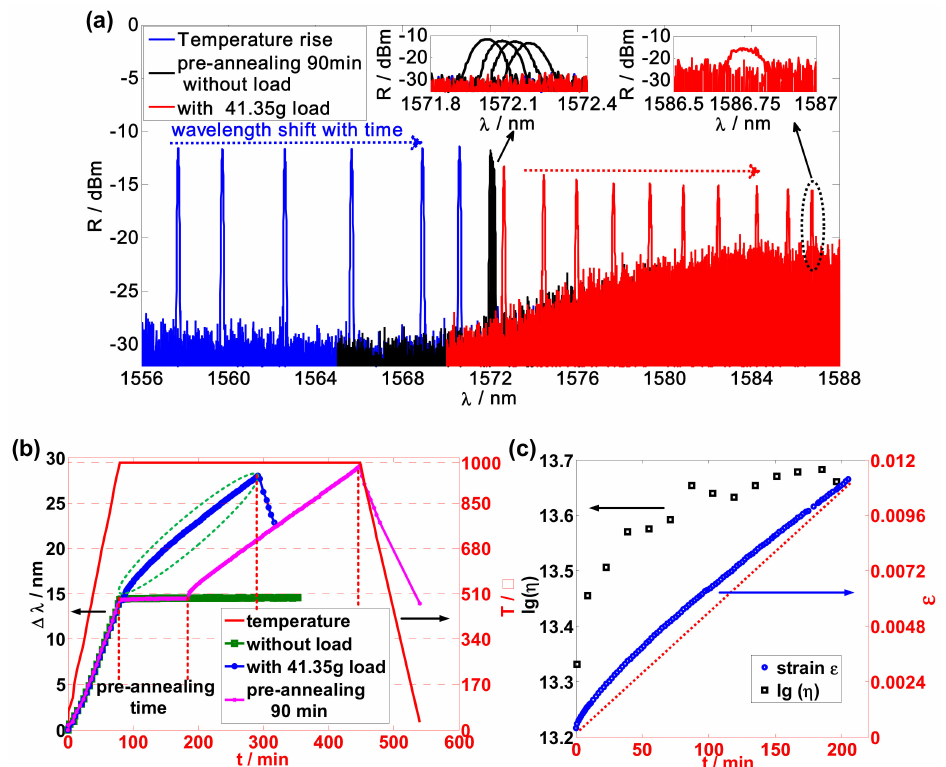
Figure 2. ( a ) Sample spectra of a regenerated fiber Bragg grating (RFBG) during the entire experimental process: Blue lines, temperature-rise process of about 80 min, then maintained constant at 1000 ◦ C; black lines, preannealing for 90 min without load; red lines RFBG spectrum with 41.35 g load; ( b ) Wavelength shift during experimental process. Three representative experiment situations are shown; ( c ) Strain ε and lg( η ) of regenerated grating with a 41.35 g